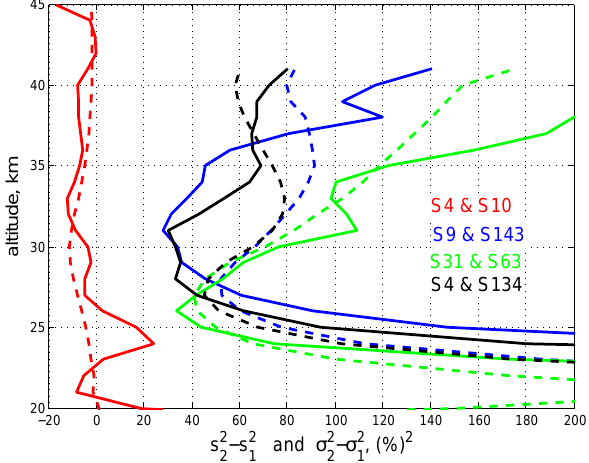
− s 2 (solid lines) and the 2 1 − σ 2 (dashed lines), for differ- 2 1